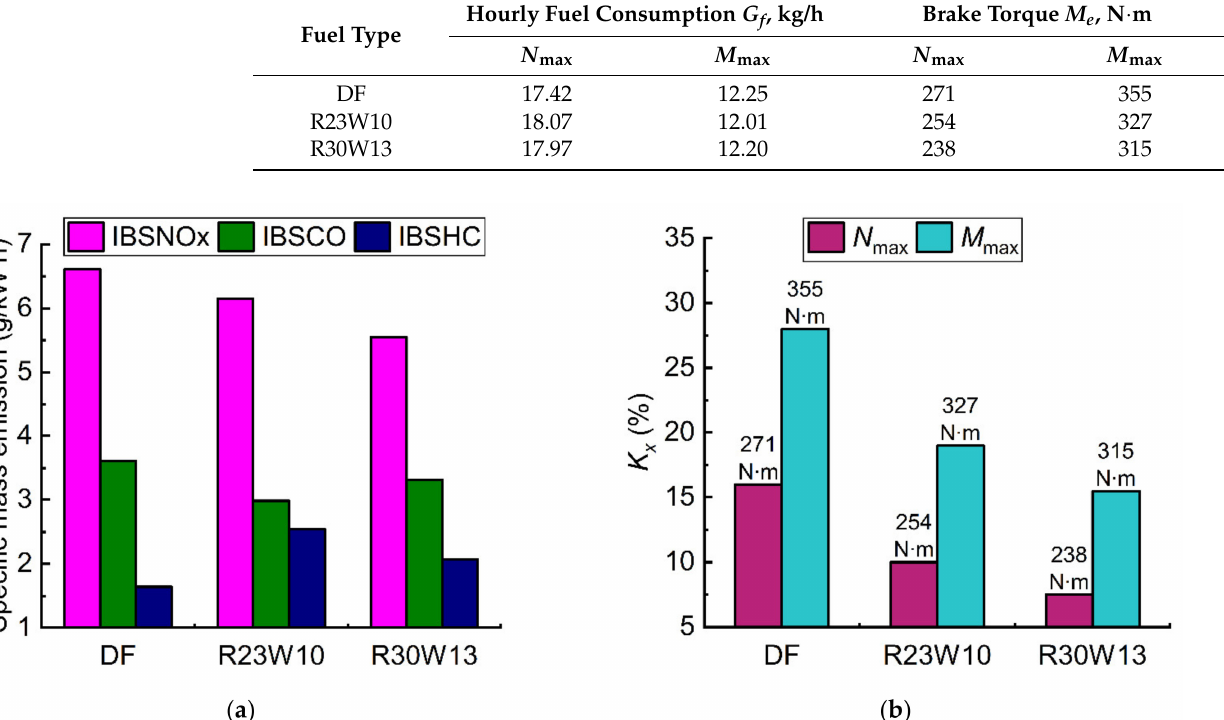
Figure 8. IBSNOx, IBSCO, and IBSHC for DF and emulsified multicomponent biofuels at the 13-mode test cycle ( a ) and exhaust smoke opacity K x on the Hartridge scale in the maximum power ( N max ) and maximum torque ( M max ) modes ( b ).